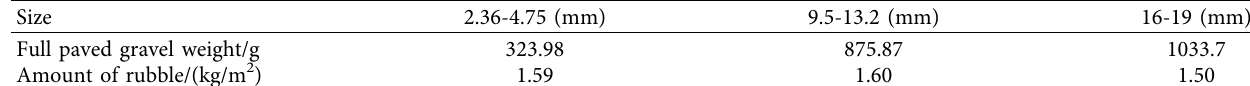
Figure 14: 2.36-4.75mm original image and inspection image. Table 8: Spreading amount and full coverage of different specifications of gravel.